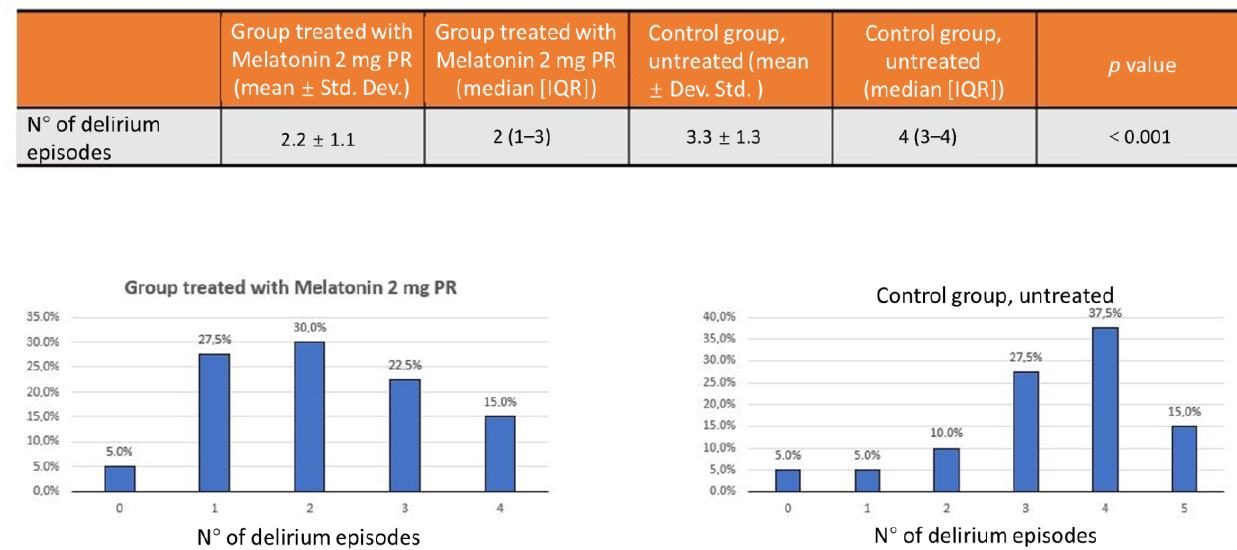
Figure 3. Significant reduction of episodes of delirium in the group treated with melatonin PRM 2 mg: 30% episodes in the median versus 37.5% episodes in the untreated group.